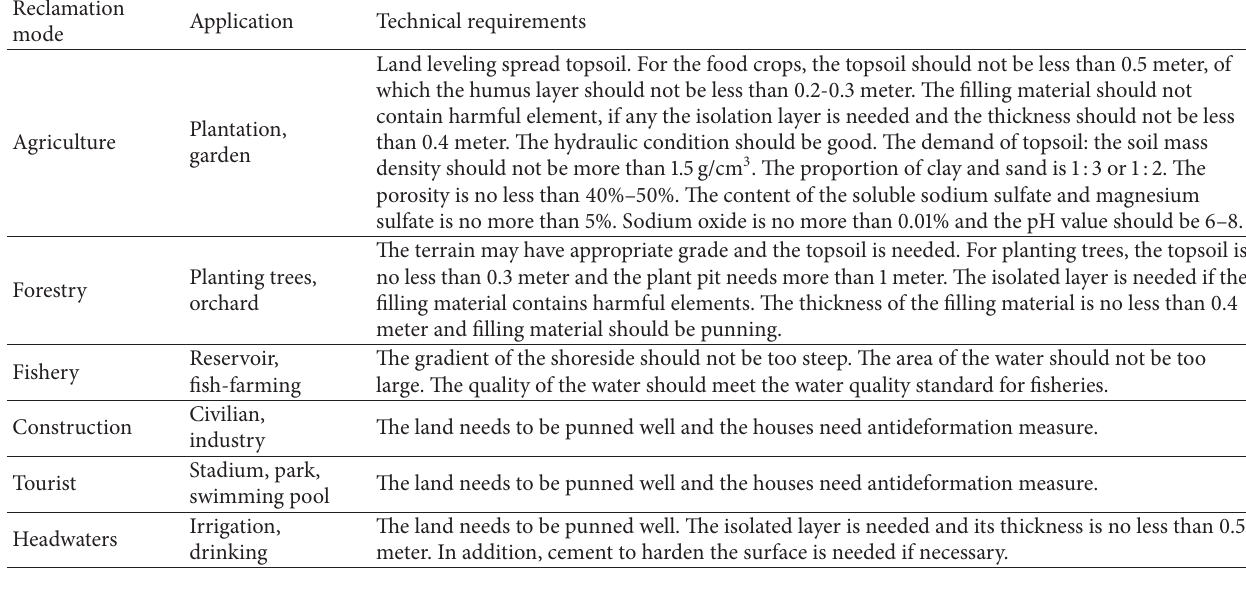
Table 1: Technical requirements of the land reclamation mode.